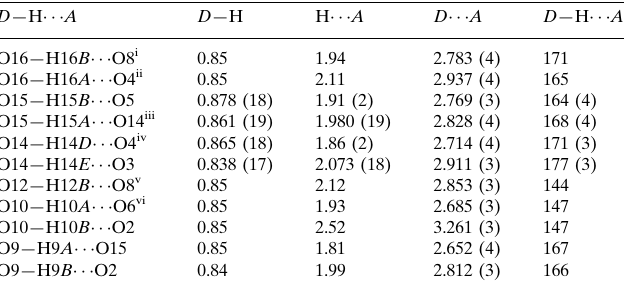
Hydrogen-bond geometry (A˚ , (cid:3)